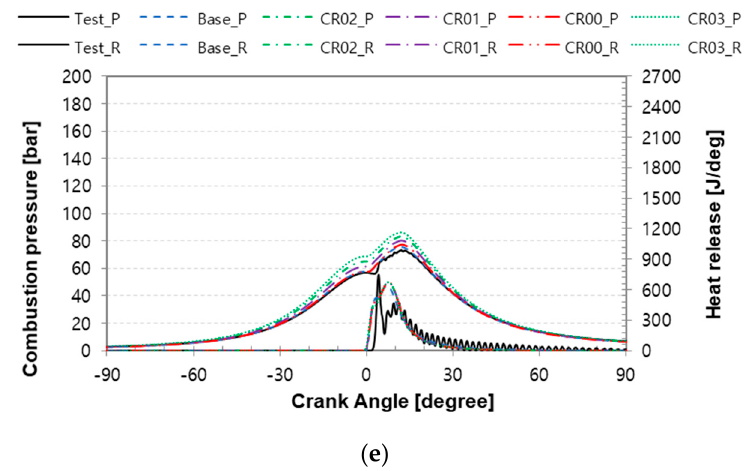
Figure 5. Combustion pressure and heat release characteristics versus the compression ratio of the turbocharger at Emulsified MDO 13%. ( a ) 100% of engine loads. ( b ) 75% of engine loads. ( c ) 50% of engine loads. ( d ) 25% of engine loads. ( e ) 10% of engine loads.